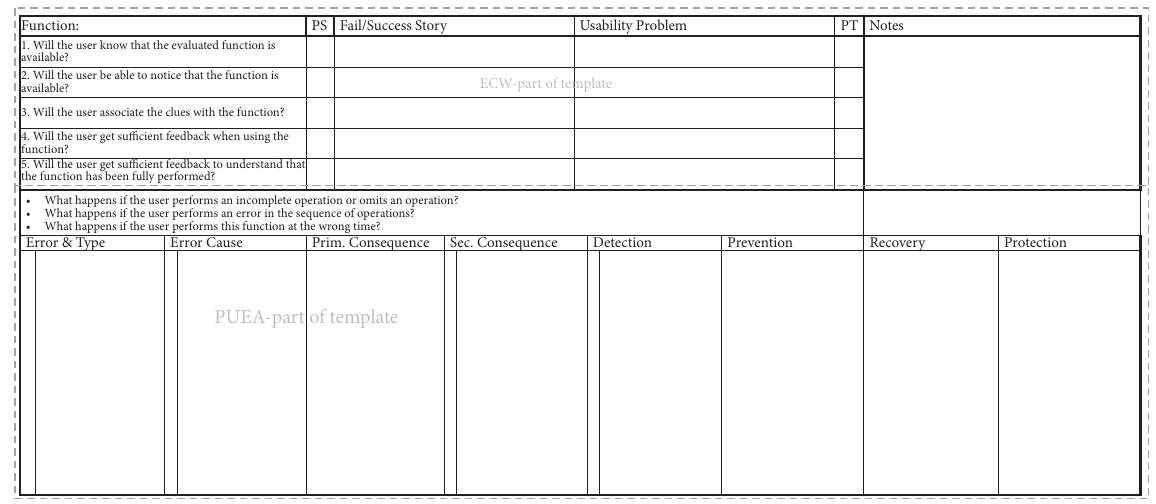
Figure 1: Template for function level analysis for the conjoint use of ECW and PUEA.